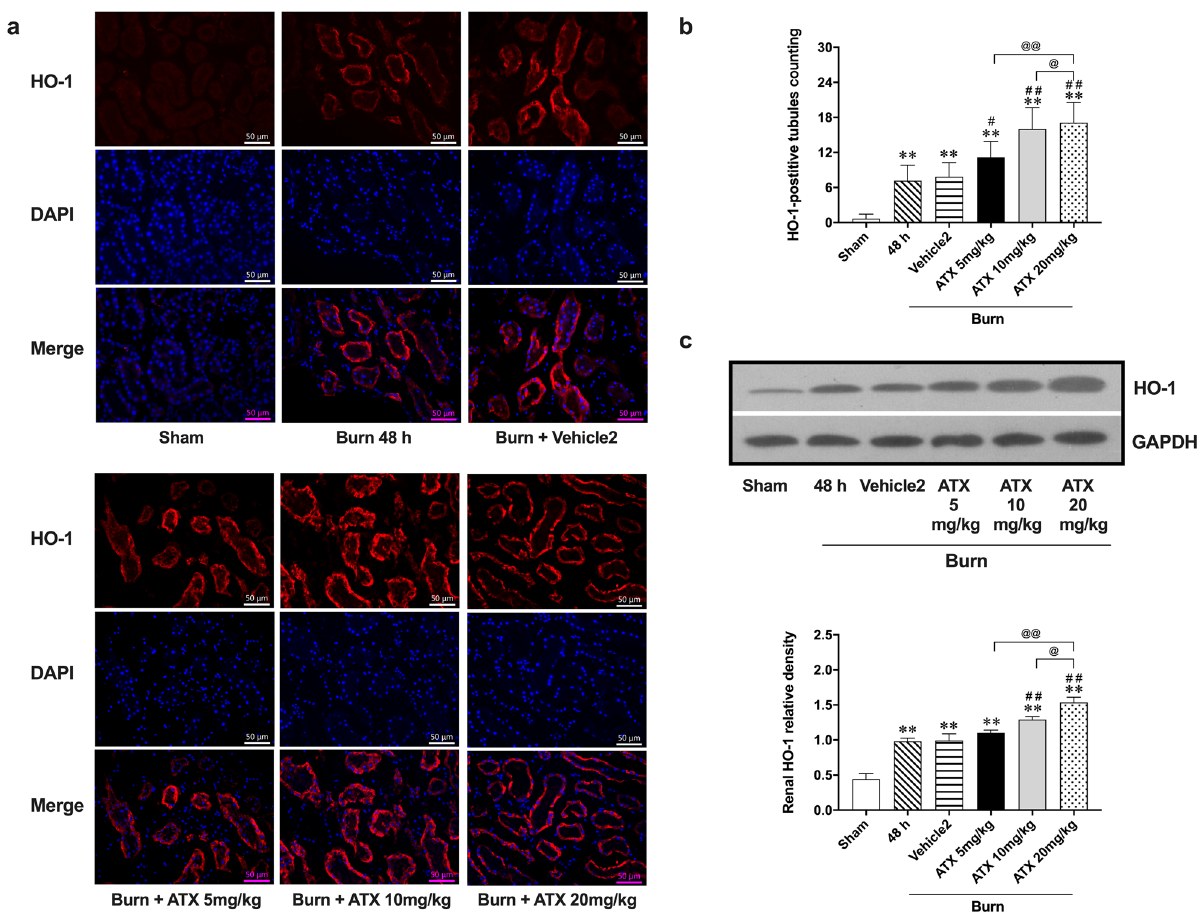
Figure 7. Astaxanthin treatment dose-related increased the distribution and expression of HO-1 in kidneys of burned rats. ( a ) Representative images of Immunofluorescence staining of HO-1 in Kidneys; ( b ) The double- blind counting of HO-1 positively-stained tubules (red-labeled) n = 12 per group; ( c ) Representative bands of HO-1 protein expression, n = 6 per group. . The results are expressed as the mean ± SD. * p < 0.05, ** p < 0.01, v.s. sham; ## p < 0.01, v.s. vehicle2; @ p < 0.05, @@ p < 0.01, ns p >